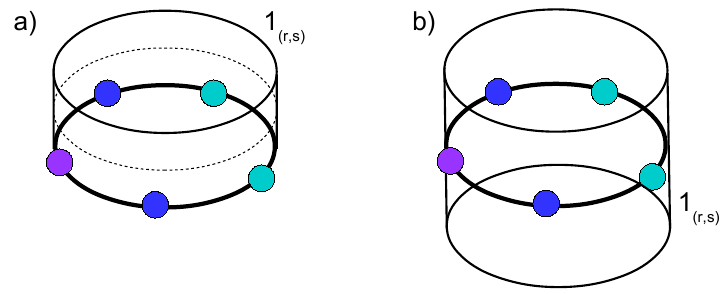
, inserting V + . (b) Brane setup leading to ( r;s ) ( r;s )